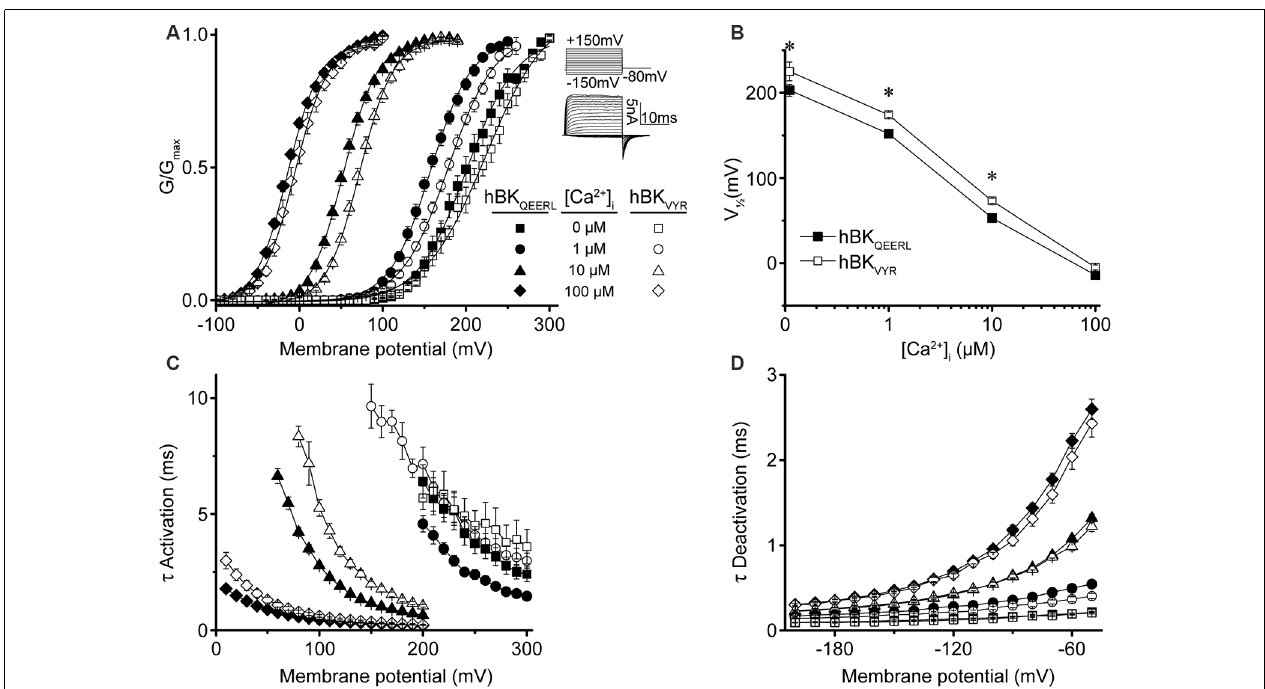
FIGURE 2 | hBK QEERL and hBK VYR current properties in symmetrical K + . (A) G–V relationships for macroscopic hBK QEERL and hBK VYR currents recorded in symmetrical K + at 0-, 1-, 10-, and 100- µ M Ca 2 + . Inset : voltage-step protocol and representative currents from hBK QEERL channels at 100- µ M Ca 2 + . Currents were evoked from a holding potential of − 100 mV using 20-ms voltage steps from − 150 up to +300 mV, in +10 mV increments, followed by a 10-ms tail step to − 80 mV. (B) V 1 / 2 vs. Ca 2 + relationship exemplifying the difference in voltage dependence of activation between hBK QEERL and hBK VYR at 0- ( P = 0.006), 1- ( P < 0.0001), and 10- µ M Ca 2 + ( P = 0.002). ∗ P < 0.05, two-way ANOVA with Bonferroni post hoc test between constructs across all Ca 2 + conditions. (C) Time constants of activation ( τ Activation) vs. voltage. hBK VYR exhibited slower activation at 1- ( P = 0.01), 10- ( P < 0.0001), and 100- µ M Ca 2 + ( P = 0.001). (D) Time constants of deactivation ( τ Deactivation) vs. voltage at each Ca 2 + concentration. Deactivation currents were elicited from a holding potential of − 100 mV using 20-ms voltage steps to +200 mV, followed by 10-ms voltage steps from − 200 to − 50 mV (in +10 mV increments). hBK VYR exhibited faster deactivation at 1- µ M Ca 2 + ( P = 0.003). Differences in current kinetics were determined using two-way repeated measures ANOVAs with Bonferroni post hoc tests. N = 8–28 recordings per channel variant at each Ca 2 +